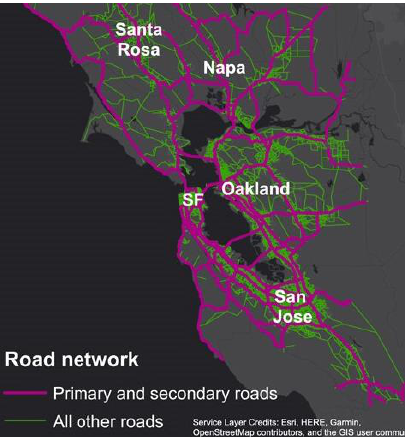
Figure 3. © Road Network Configuration of San Francisco Bay area, USA (Esri, 2022). lines show All other roads in San Francisco Bay area)